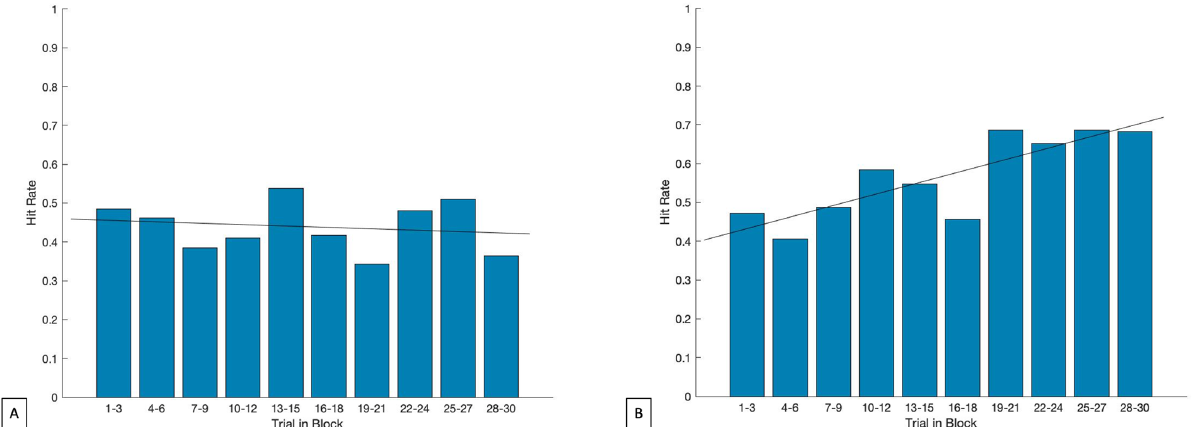
Figure 5. Lag-1 performance is not limited by capacity-dependent visual processing, but rather sufficient time to engage the T2 attentional boost. Average T2 hit rate (y-axis) across a bin of 3 consecutive trials (x-axis). A total of 10 bins are shown, representing results from all trials (1–30). Best fit line (black) from least squares regression of target hit rates over the 30-trial block. ( A ) Experiment 4 (unaware, N = 14 subjects), participants did not demonstrate learning when unaware of the sequence preceding the target. ( B ) Experiment 4 (aware, N = 13), participants demonstrated significant learning compared to the 50 ms SOA accuracy from Experiment 1 ( p <